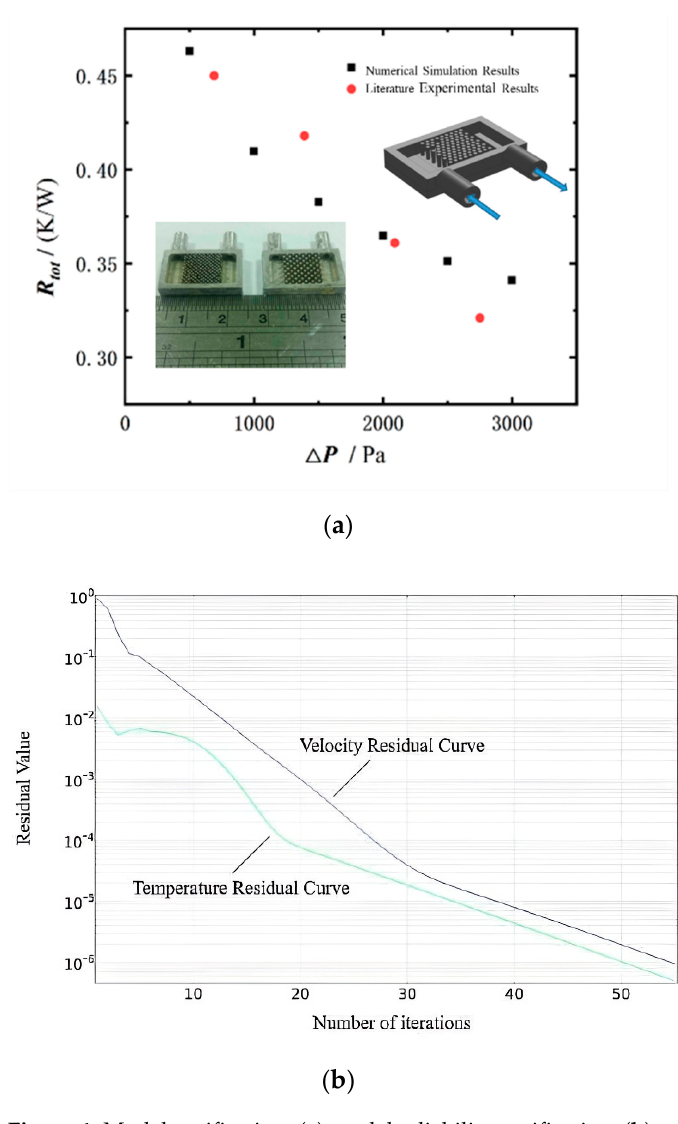
Figure 4. Model verification: ( a ) model reliability verification; ( b ) calculation residual curve.